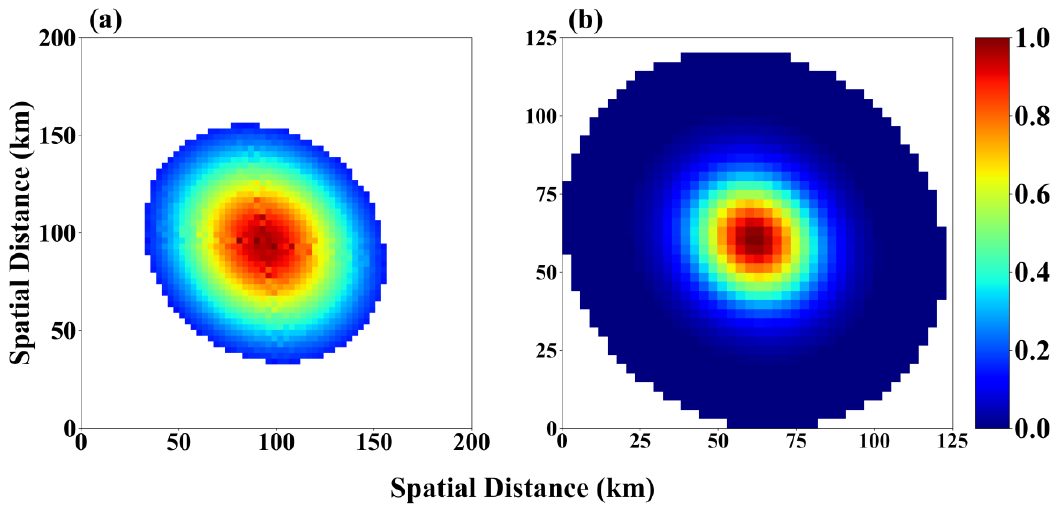
Figure 8. ATMS ( a ) channel-1 and ( b ) channel-3 PSFs projected from Gaussian-shaped antenna patterns.